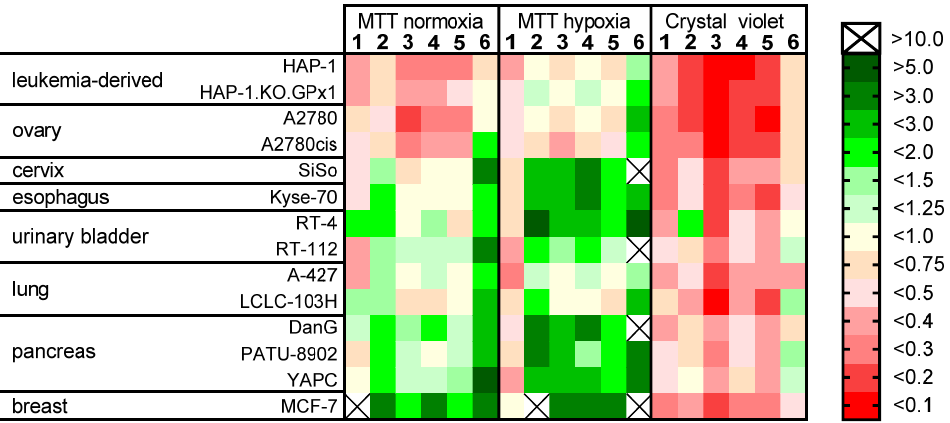
Figure 6. Heatmap summarizing the mean IC 50 and GI 50 values in micromolars after treatment of a panel of 14 human cancer cell lines with pentathiepins 1 – 6 determined with MTT assay under normoxic and hypoxic conditions, and with the crystal violet assay under normoxia. The corresponding values with SD are available in Table S3. n ≥ 3 independent experiments.